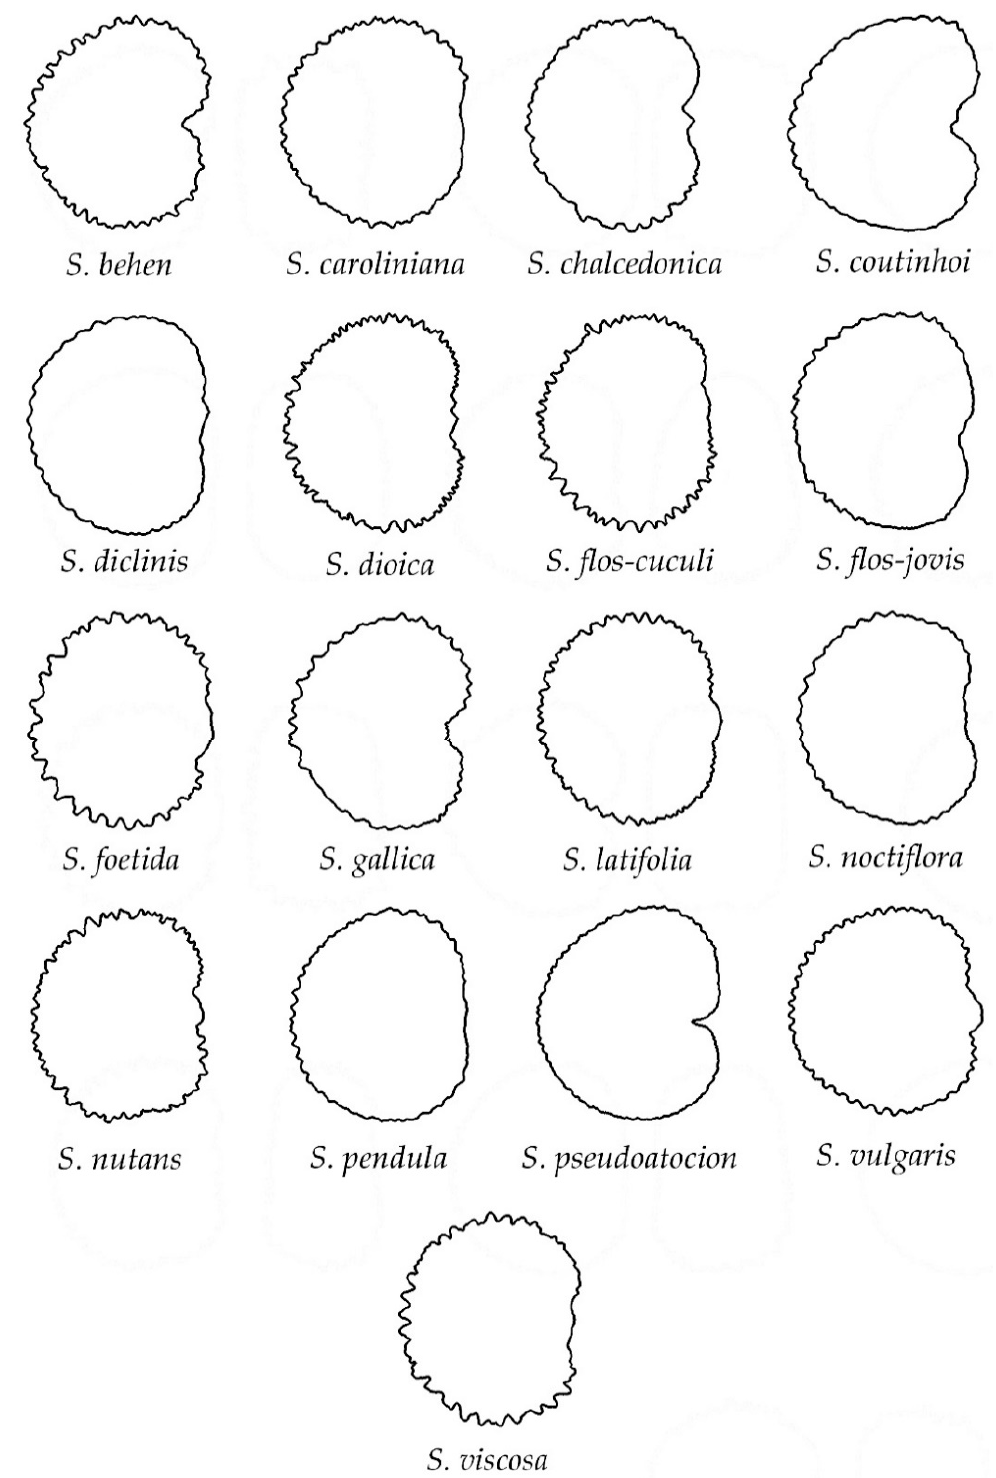
Figure 6. Lateral views of the silhouettes of Silene seeds belonging to the group of echinate seeds. Conversely to the two previous groups of seeds, the dorsal view of the echinate seeds were predominantly convex (or rarely truncate rectangular, e.g., S. coutinhoi ), character- ized by the lack of a depression in both upper and lower part of the seeds and with a margin, in general, notably rugose or echinate (Figure 7).